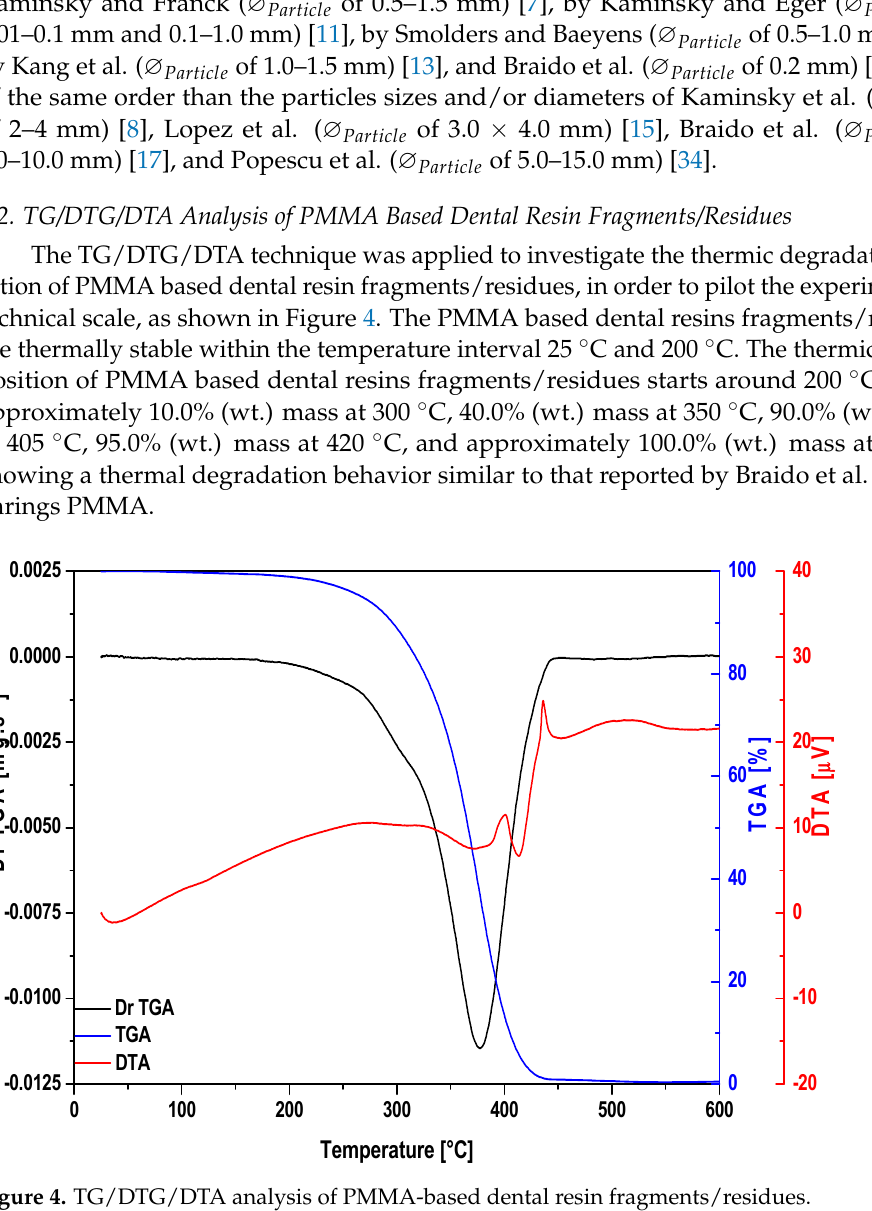
pheric pressure, in pilot scale.